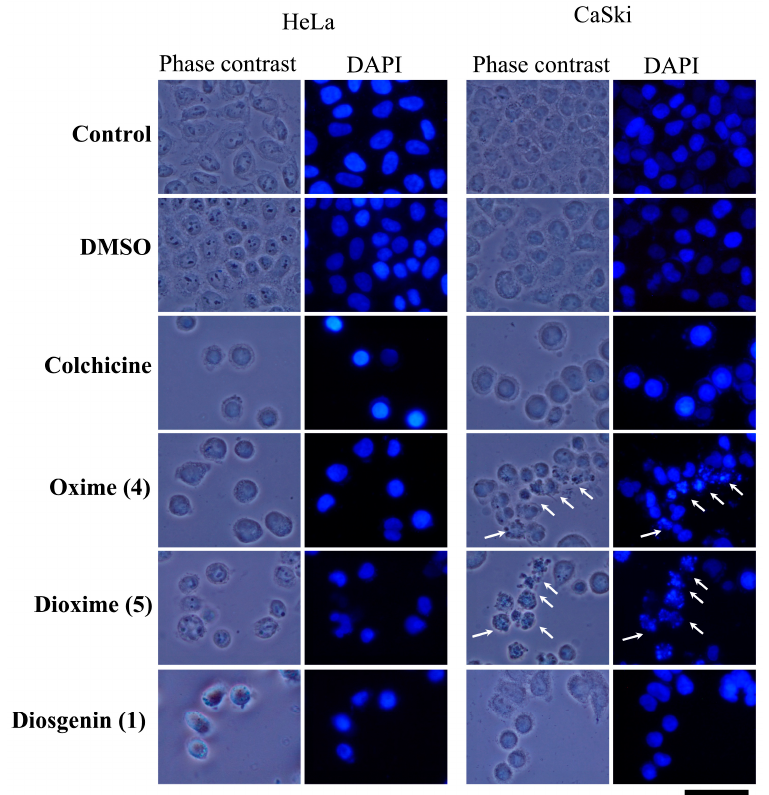
Figure 5. Apoptotic morphology induced by 1 , 4 , and 5 compounds on cervical cancer HeLa and CaSki cell lines. Phase contrast allows identifying the normal polyhedral morphology in control and vehicle treated cells; the normal chromatin is evident with the DAPI staining. Colchicine treated cells (positive control to apoptosis) have a spherical shape, with cytoplasmic and nuclear compaction. Compounds 1 , 4 , and 5 cause cell morphological changes corresponding to the apoptosis morphology. Apoptotic bodies are more evident in 4 and 5 than in 1 (arrows). Scale bar 50 microns.